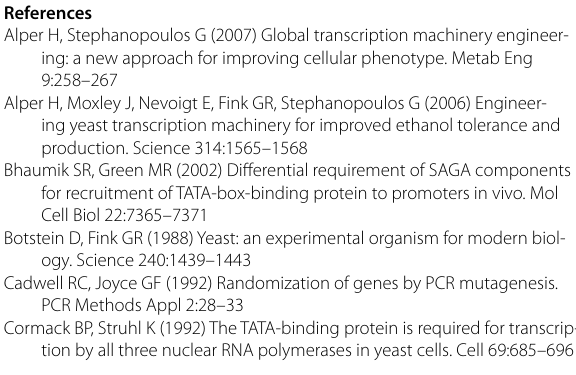
towards higher concentrations of ethanol. All the exam- ined mutants showed much better tolerance toward etha- nol stress as compared to the R-control. The mutants resulted by using 3% of MnCl 2 in the process of Ep-PCR recorded the highest ethanol production. In a prospec- tive study, we seek to establish a basis for future indus- trial applications, through integrating the SPT15 mutant alleles of two new mutant strains into the chromosomes, to enhance ethanol tolerance and survive with high con- centration of ethanol in the media.